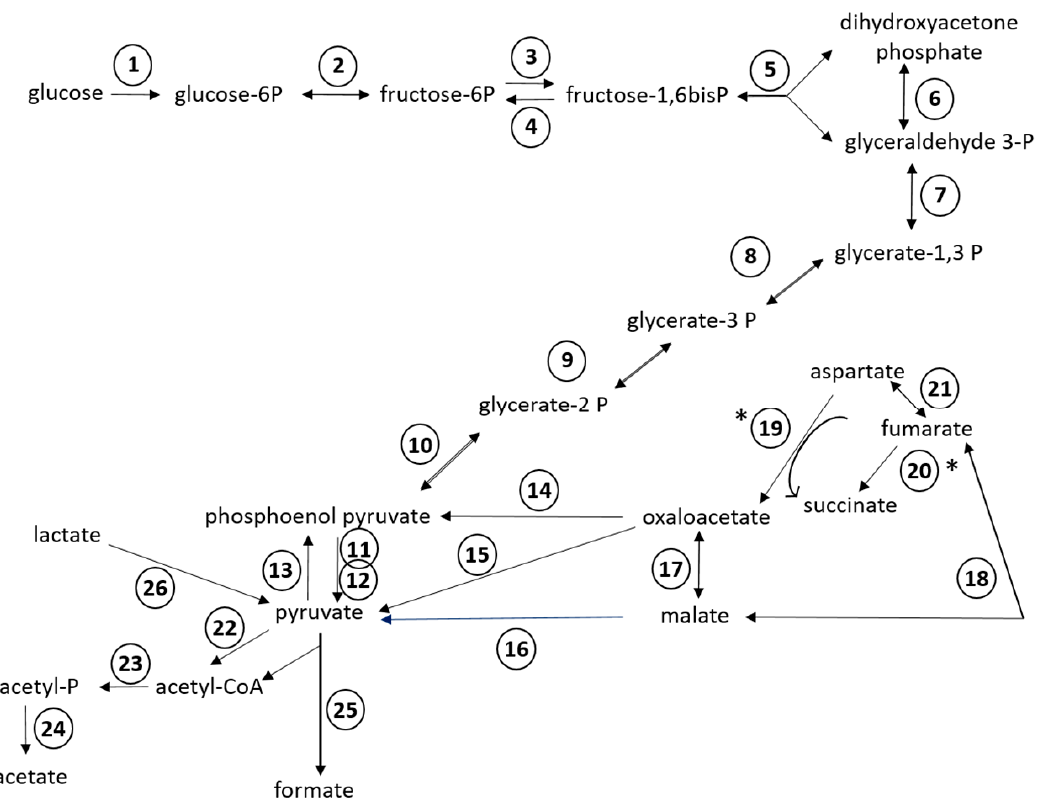
Figure 2. Predicted metabolic reactions for fermentation of glucose into short chain fatty acids (SCFAs) from the annotated genomic sequences of SD_Bt-00010. Unidirectional arrows indicate that an enzyme is predicted to only catalyze a reaction in one direction, while bidirectional arrows indicate that the same enzyme can catalyze both forward and reverse reactions [36]. (*) indicates the predicted direction under anaerobic conditions. Enzymes displayed are: (1) hexokinase (EC 2.7.1.2); (2) glucose- 6-phosphate isomerase (EC 5.3.1.9); (3) 6-phosphofructokinase (EC 2.7.1.11); (4) fructose-1,6-